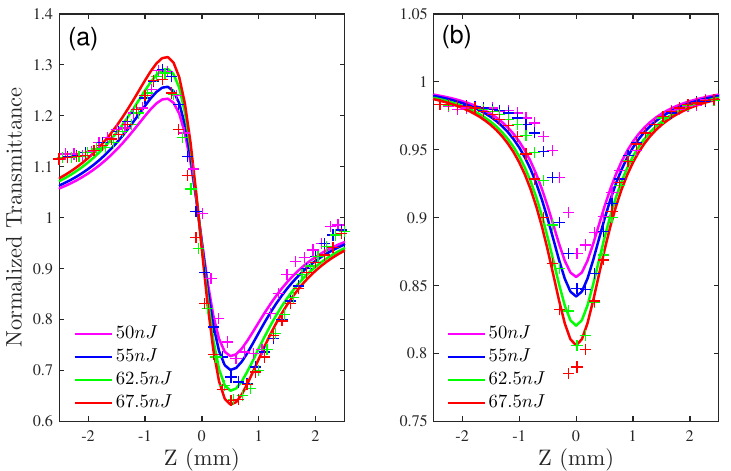
Figure 2. The experimental (dots) and fitting (solid lines) results of the Z-scan measurements for the 15 µ m-thick p -Si sample at 800 nm, using incident fluence of 50 (magenta), 55 (blue), 62.5 (green) and 67.5 nJ (red), respectively. ( a ) Closed aperture Z-scan (normalised transmittance with a 500- µ m aperture). ( b ) Open aperture Z-scan (normalised transmittance without